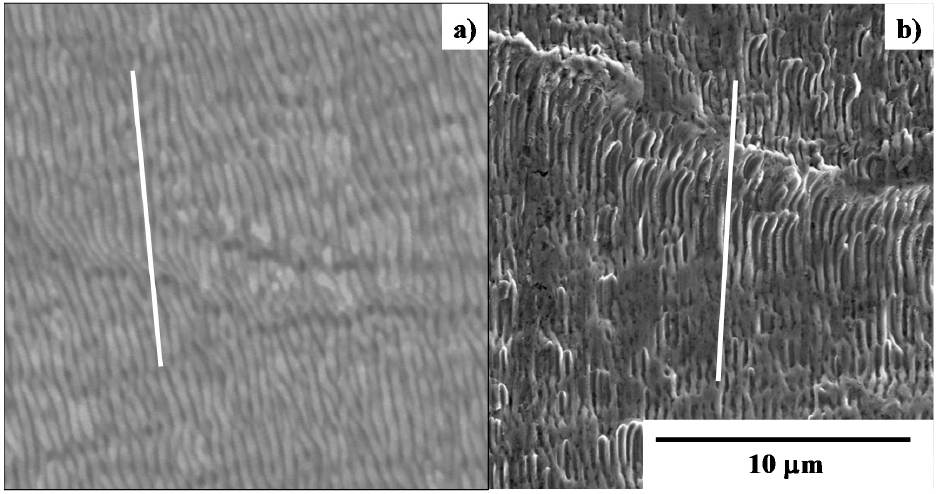
Figure 9. Comparison of the nanotextures of segment #1 in the microtexture of M6 between the punch and the coined AA1060 specimen. ( a ) Nanopattern of #1 on M6 of the AISI316 punch, and ( b ) nanotexture of #1 on the M6 of coined AA1060.